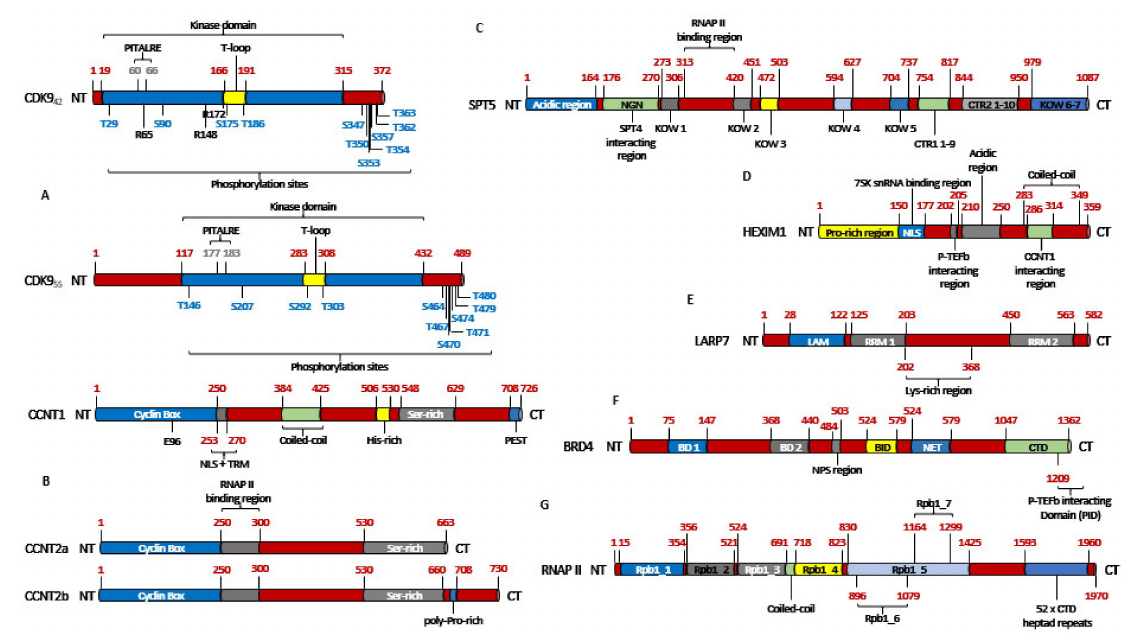
Figure 2. The domain structures of key proteins involved in P-TEFb regulated transcription. ( A ) The two CDK9 isoforms expressed in most cells. The CDK9 55 is longer than the CDK9 42 by 117 amino acids (aa) at the N-terminus (NT) as the former isoform is transcribed by a different promoter, <500 bp away from the later, on the CDK9 gene. The aa highlighted in blue represent the key phosphorylation sites on CDK9. The PITALRE region is marked in light black. While the three acetylation sites are highlighted in black ( B ) The three main cyclins that partner with CDK9. The main acetylation site E96 is highlighted in black on Cyclin T1 ( C ) SPT5 which is a component of the 5,6-dichloro-1- β -D-ribofuranosylbenzimidazole (DRB) Sensitivity-Inducing Factor (DSIF). It possesses upto 7 Kyrpides-Ouzounis-Woese (KOW) domains which binds to different regions of RNAP II. The RNAP II binding region of SPT5 has been highlighted in black. ( D ) HEXIM1. ( E ) LARP7 with its La-Motif (LAM) and RNA-Recognition Motifs (RRM1 and 2). The LAM and RRM1 motifs work synergistically to form a ‘V’ shaped clamp to bind to the 3 (cid:48) -UUUU-OH region of 7SK snRNA while the RRM2 binds to the apical loop of the 3 (cid:48) -hairpin of the 7SK snRNA. ( F ) BRD4 with its N-terminus Phosphorylation Site (NPS), two Bromodomains (BD1 and 2) and N-terminus Extra Terminal (NET) domain and the C-terminus P-TEFb Interacting Domain (PID). ( G ) RNAP II with its 7 Rpb1 (RNA polymerase II subunit B1) domains and the 52 Y 1 S 2 P 3 T 4 S 5 P 6 S 7 heptad tandem repeats at its